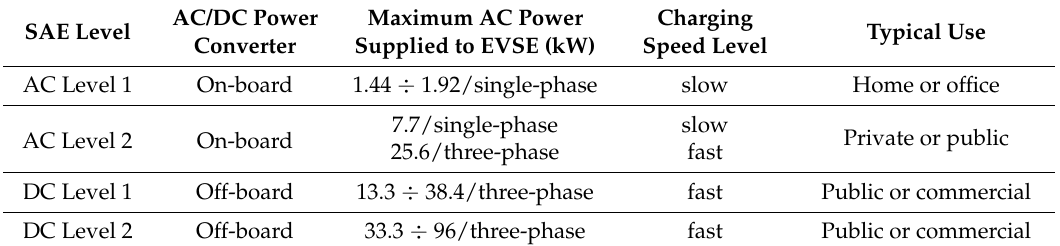
Table 1. Classification of electric vehicles charging systems according to the SAE standard J1772 [8].